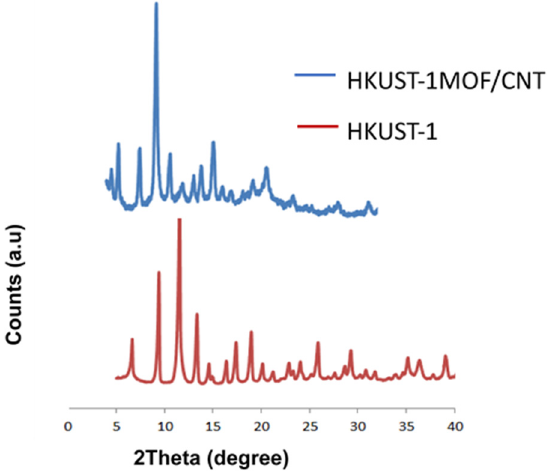
/ HKUST-1 composite.